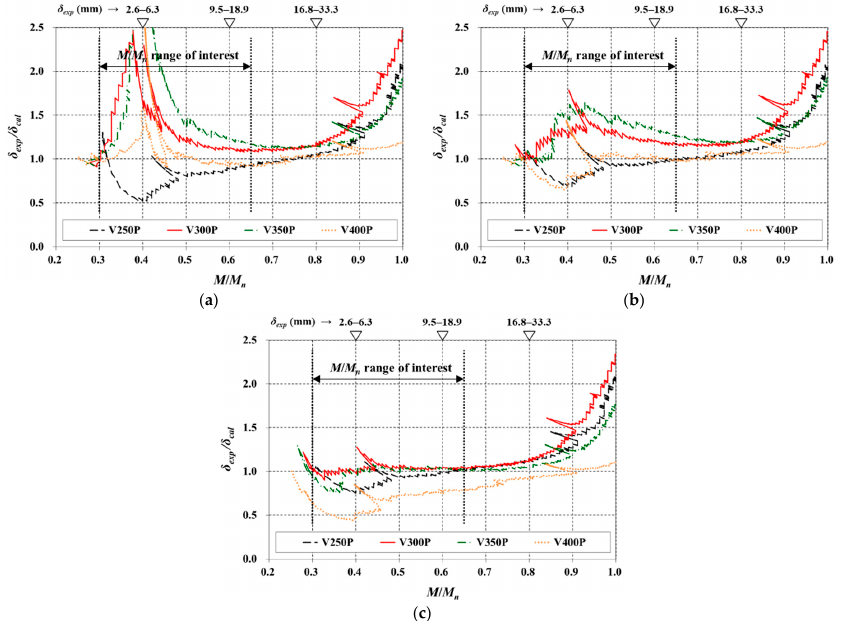
Figure 7. Comparison of immediate deflection (V slabs) based on ( a ) ACI 318 - 19; ( b ) CSA A23.3 - 19 (0.5 f r ); ( c ) 0.35 f r .